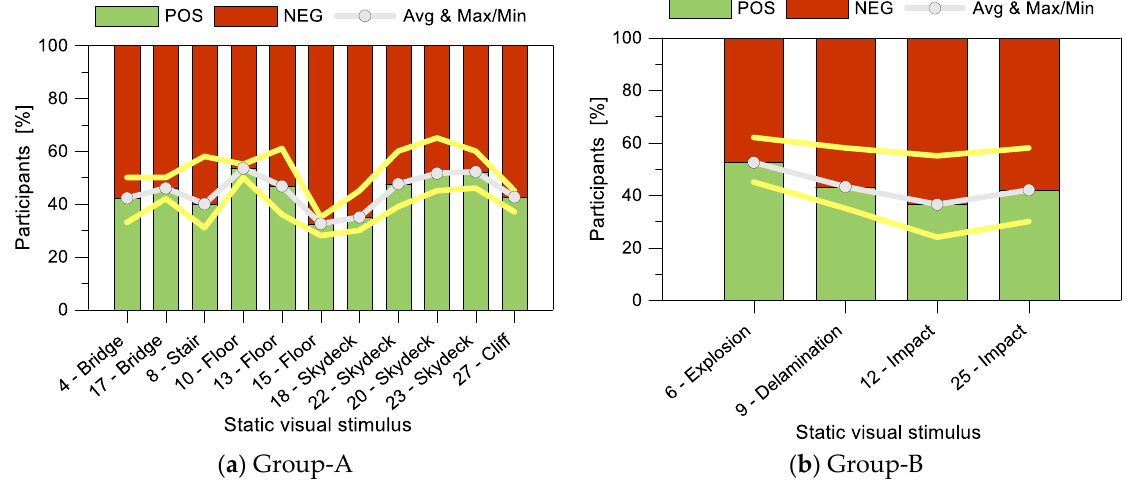
Figure 16. Detection of prevailing reactions (in percentage terms for the group of participants), as a function of static stimulus, for ( a ) Group-A or ( b ) Group-B.